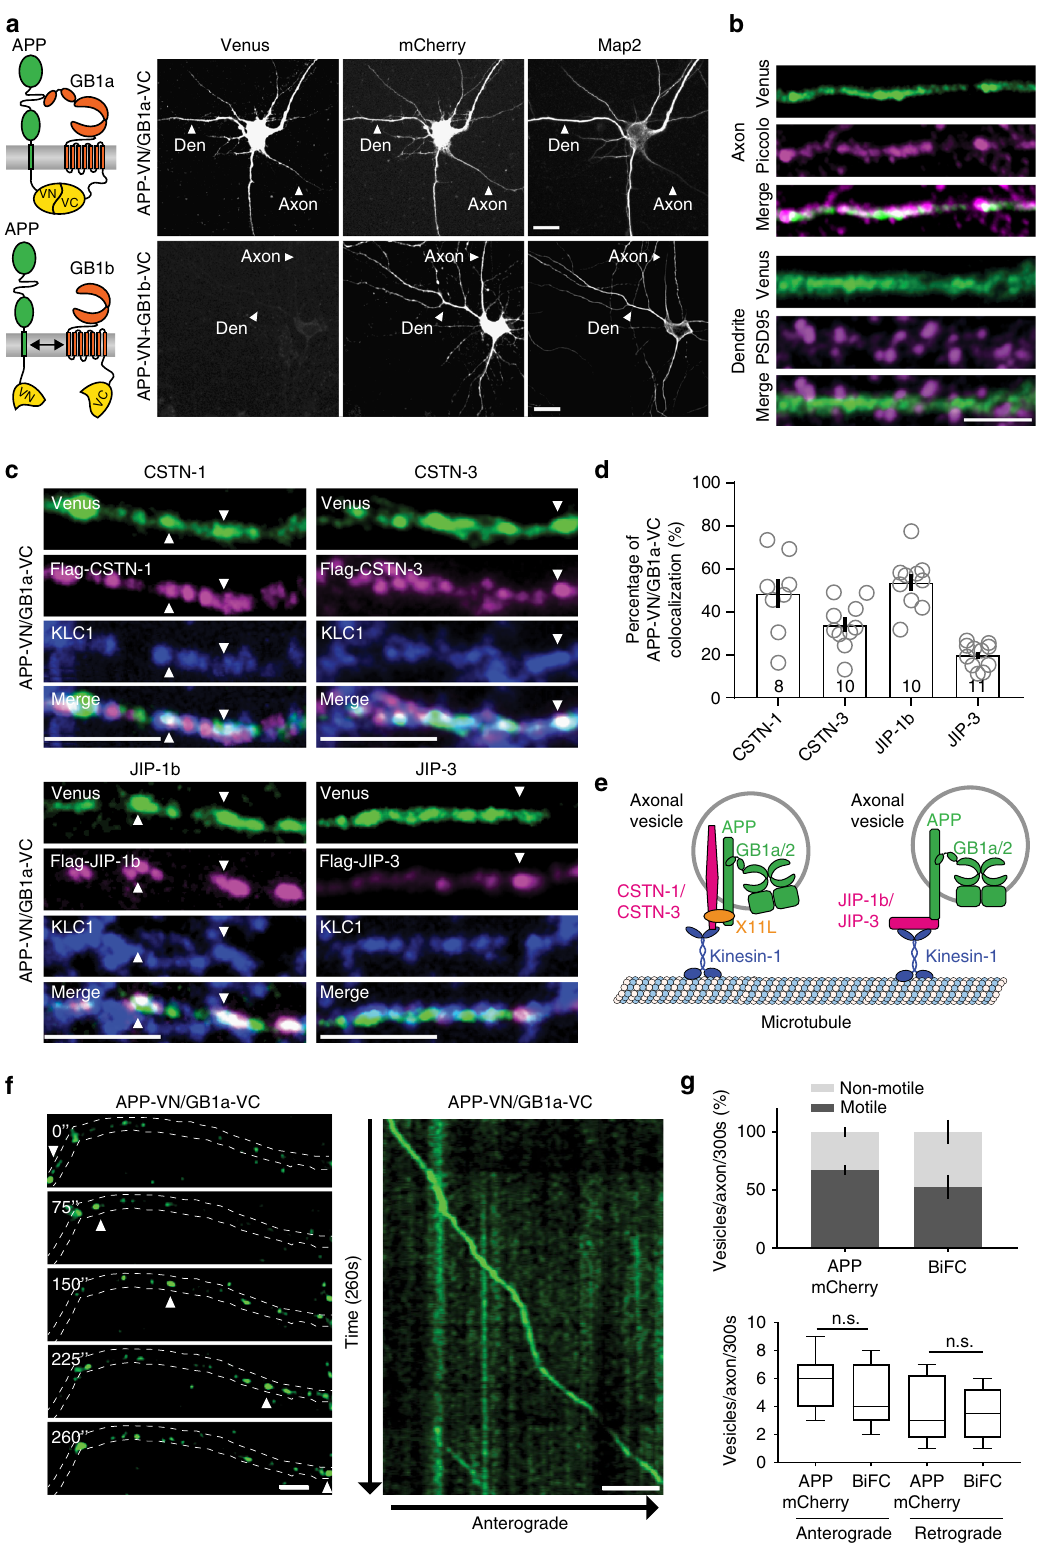
anterograde and retrograde axonal transport of APPmCherry and APP-VN/GB1a-VC BiFC complexes (Fig. 5g, Supplementary Fig. 10a), similarly as previously observed for APP 29 . The majority of APP vesicles colocalized with NPY, a marker